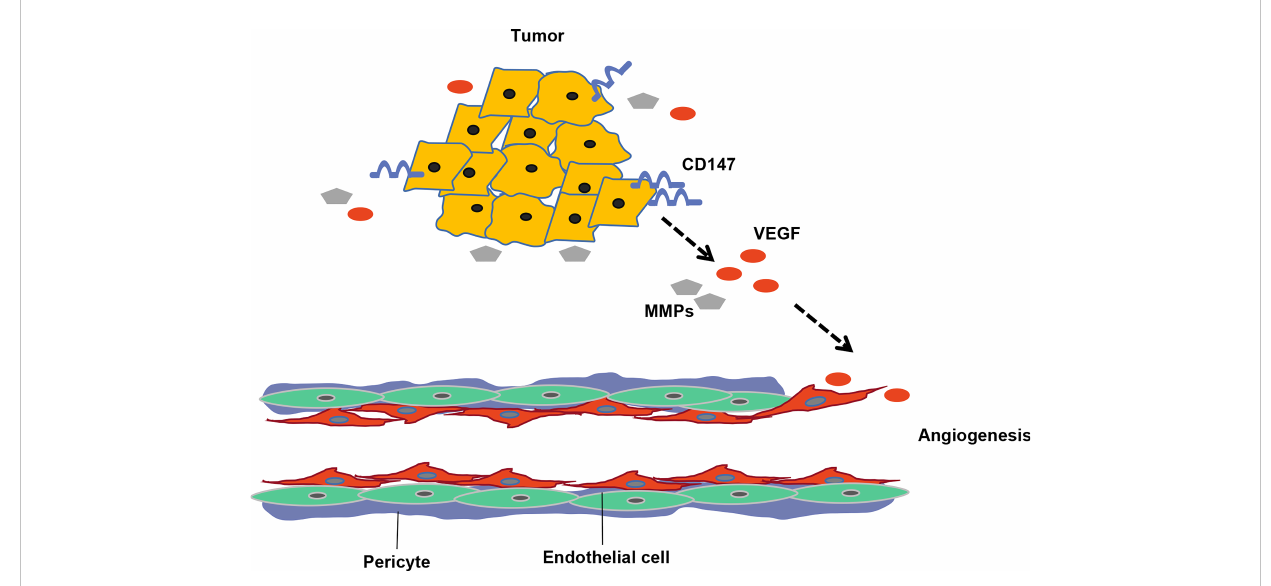
FIGURE 3 CD147 promotes hepatocellular carcinoma angiogenesis. CD147 enhances production of MMPs and VEGF thereby promoting HCC angiogenesis.